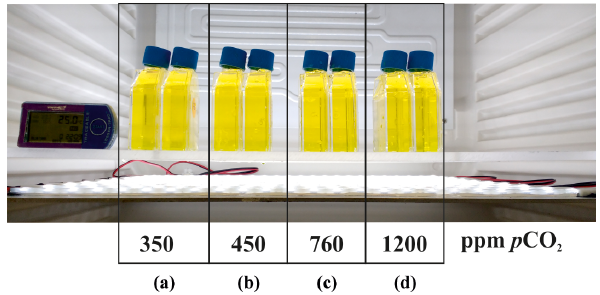
Figure 1. Photograph of the culture setup. Four duplicate bot- tles with culture media (with calcein added) and adult specimens of foraminifera. Treatments with corresponding set points are A, 350ppm; B, 450ppm; C, 760ppm; D, 1200ppm CO 2